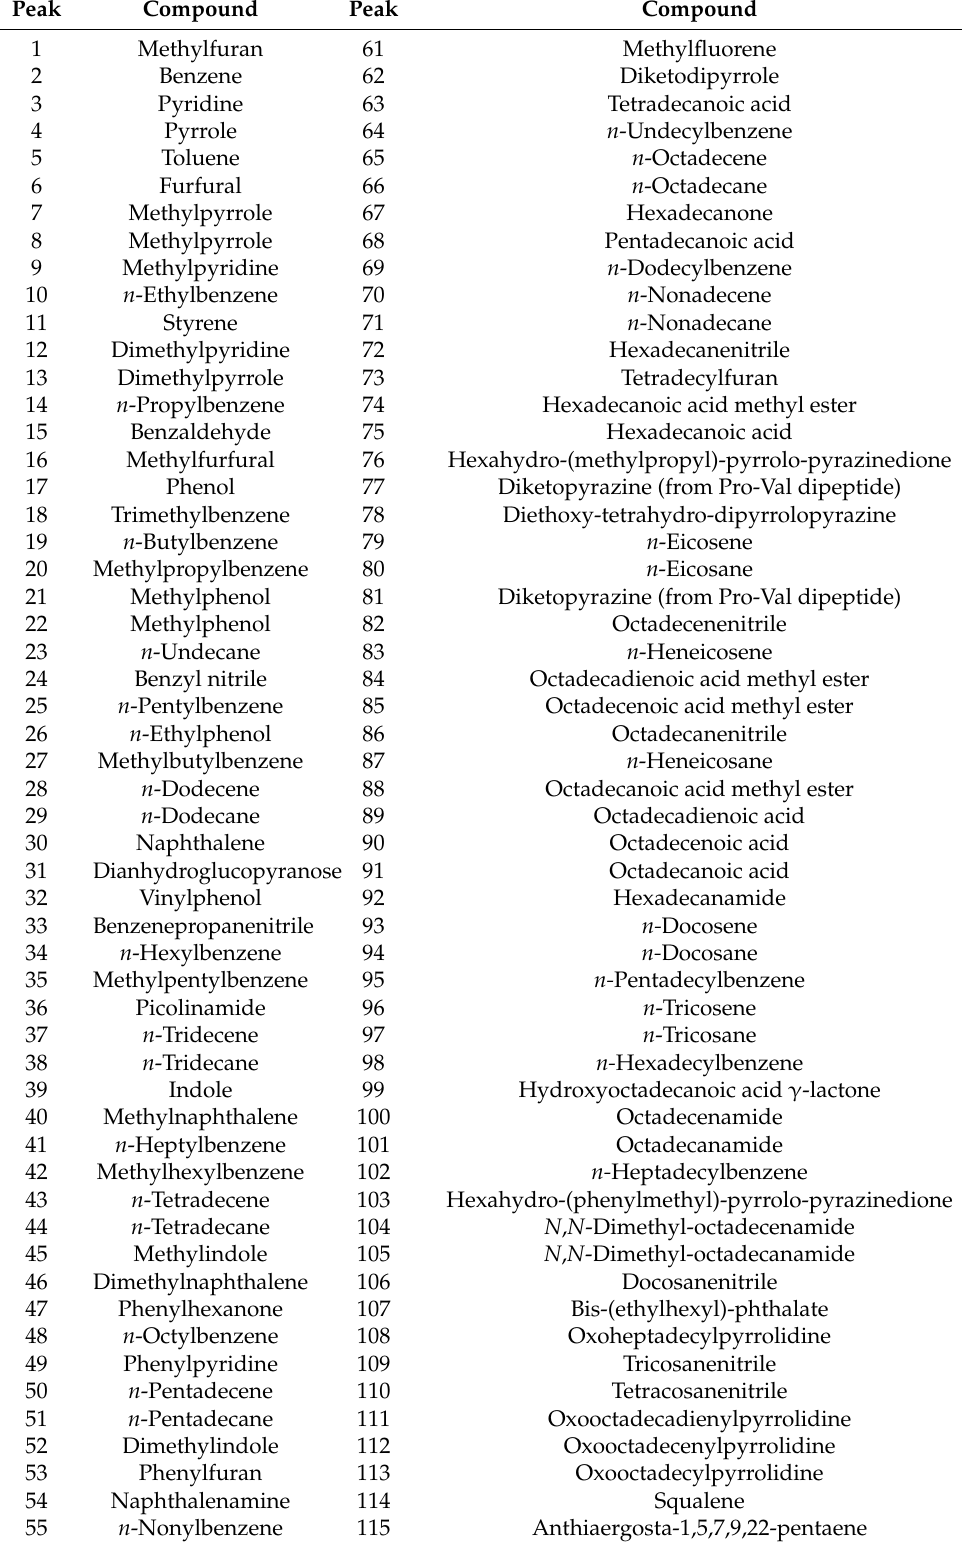
Table 1. Pyrolysis products obtained in the pyrolysis at 500 ◦ C of the melanins from three Ochroco- nis